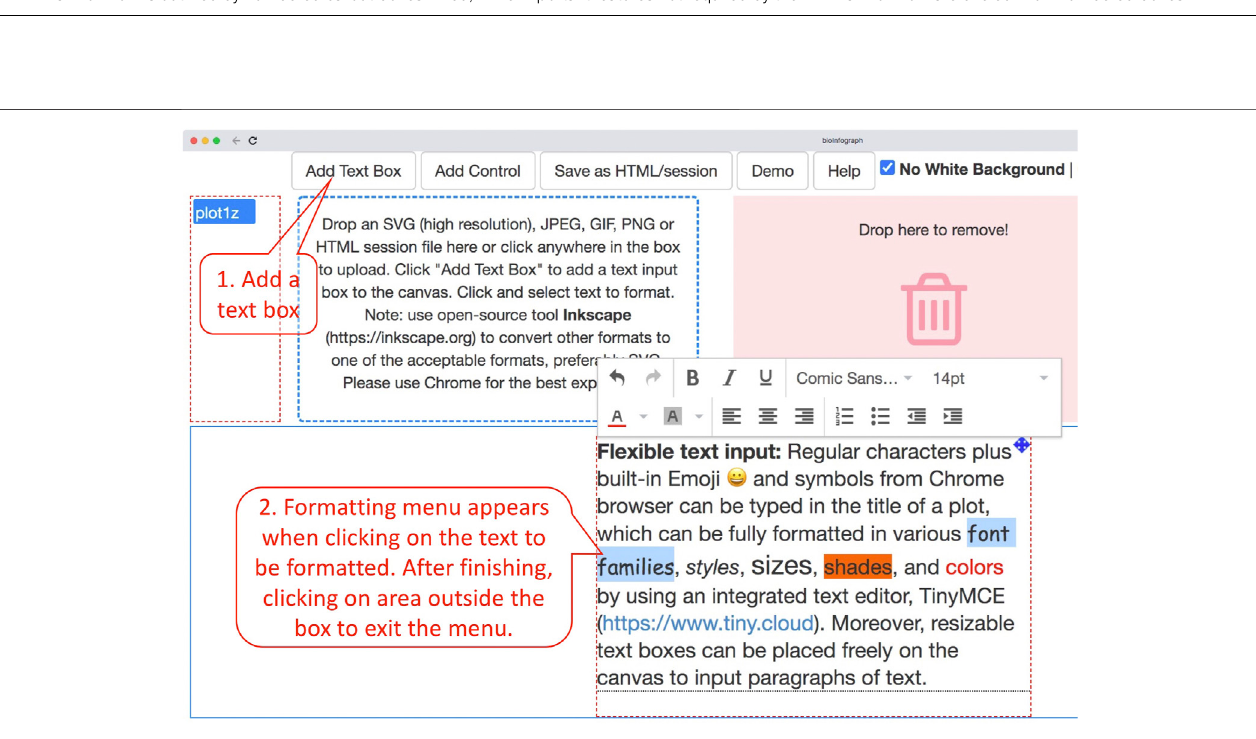
FIGURE4| Inputofparagraphsoftextbyclicking on “ AddTextBox ” andthentypingintheresizableboxthatwasaddedtothecanvasamomentago.Clickingon the text will fi re up the formatting menu, while clicking on any area outside the box will exit the menu. Formatting is always applied to selected text.